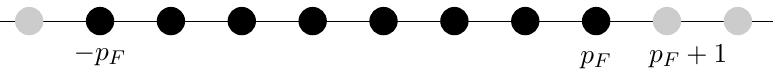
Figure 11 . Maya diagram for the ground state. The black nodes ( j p j (cid:20) p F ) are occupied by fermions while the gray nodes ( j p j > p F ) are empty.